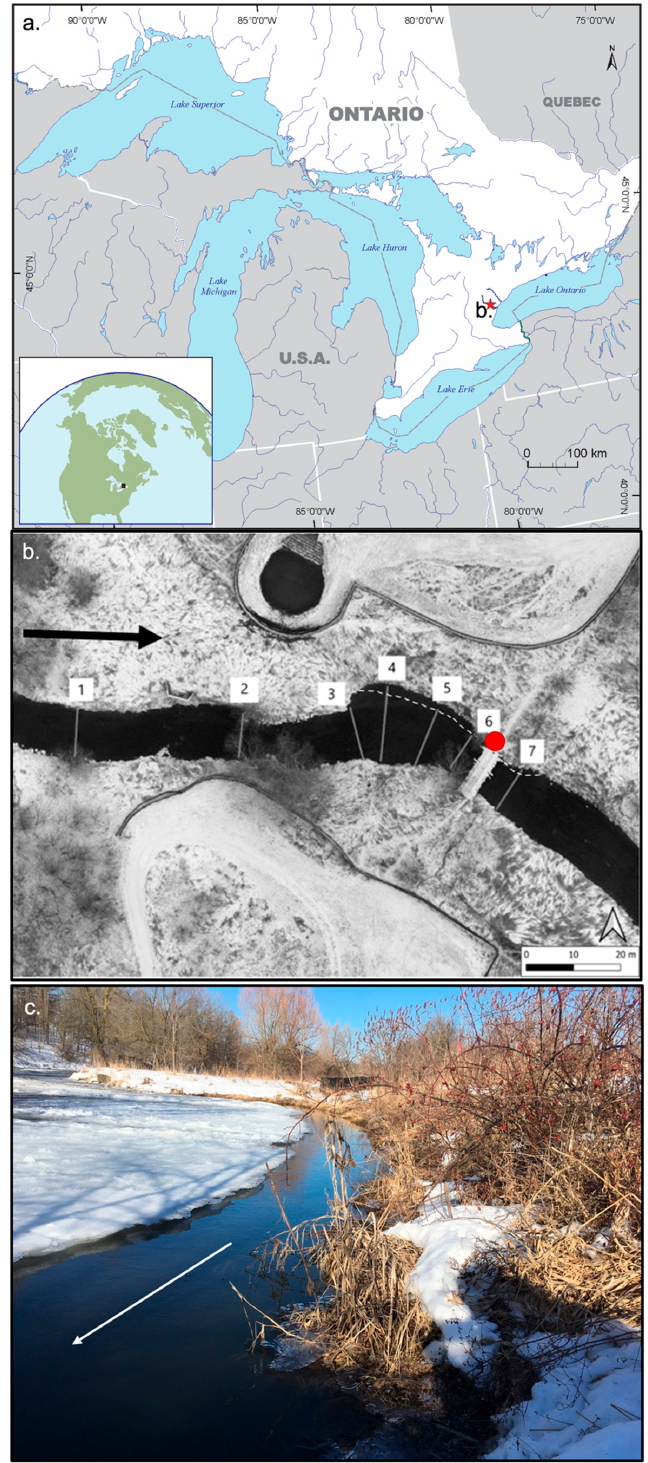
Figure 1. Sixteen Mile Creek is a small, low-order stream in southern Ontario, Canada. ( a ) Study reach location relative to the Laurentian Great Lakes and ( b ) aerial photograph showing numbered cross-section locations through the study reach. Flow direction is from left to right, as indicated by the large black arrow along the left bank. The dashed line along the left bank indicates ice extent. ( c ) Photograph looking upstream along the left bank (red dot on ( b )) showing the thin (~1 m) strip of open water on 25 February 2021 (two days after the major sampling campaign on 23 February 2021). The white arrow in the photograph indicates flow